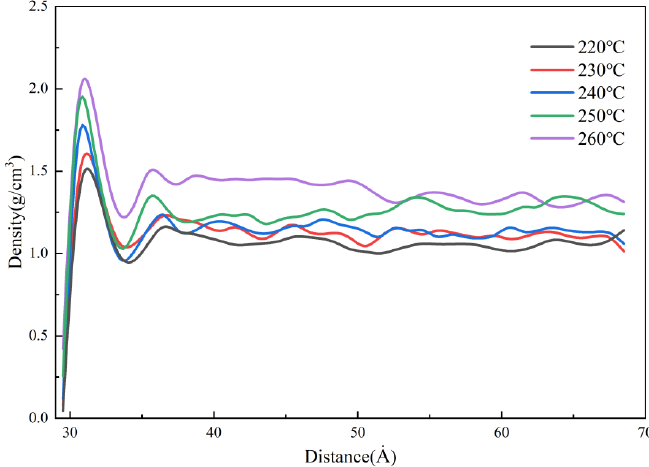
Figure 23. Density distribution at different melt temperatures along the flow direction.